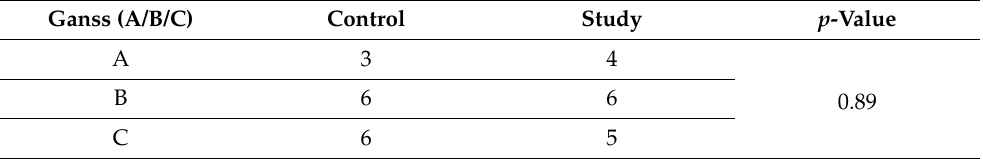
Table 1. Calculation of Ganss